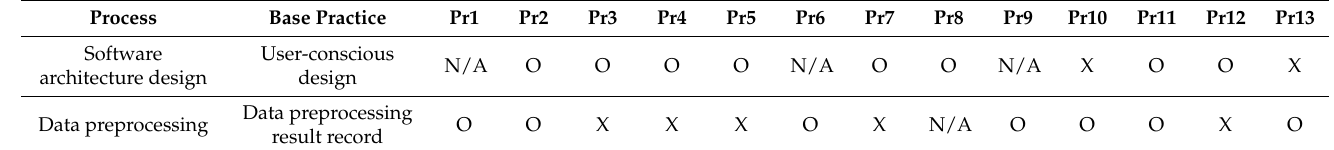
Table 11. Part of Fisher’s exact test results among base practices ( p -value is below